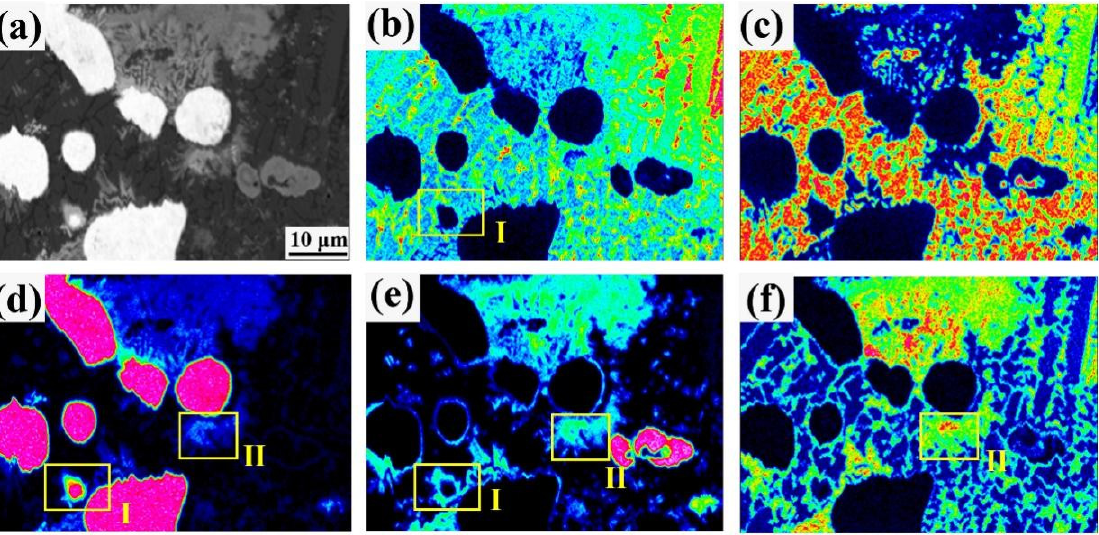
Figure 6. Elemental distribution surface scans of the Ni–Cu–15(Mo,W,Si) coating: ( a ) BSE graph of the Ni–Cu–15(Mo,W,Si) coating; ( b ) Ni; ( c ) Cu; ( d ) W; ( e ) Mo; ( f )